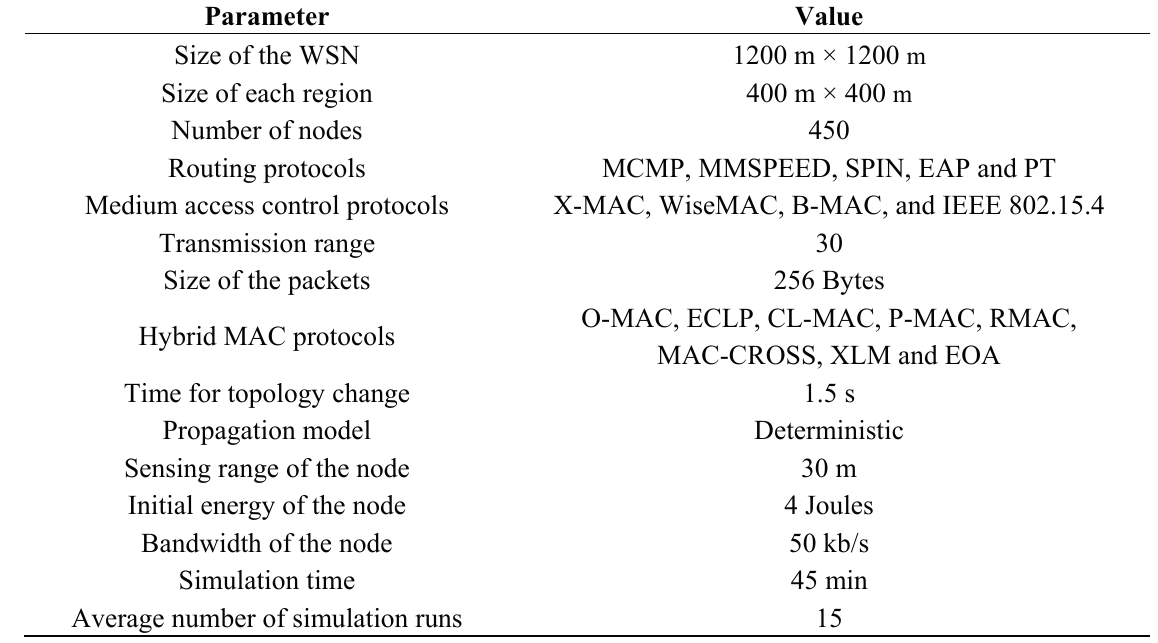
Table 7. Simulation parameters and their corresponding